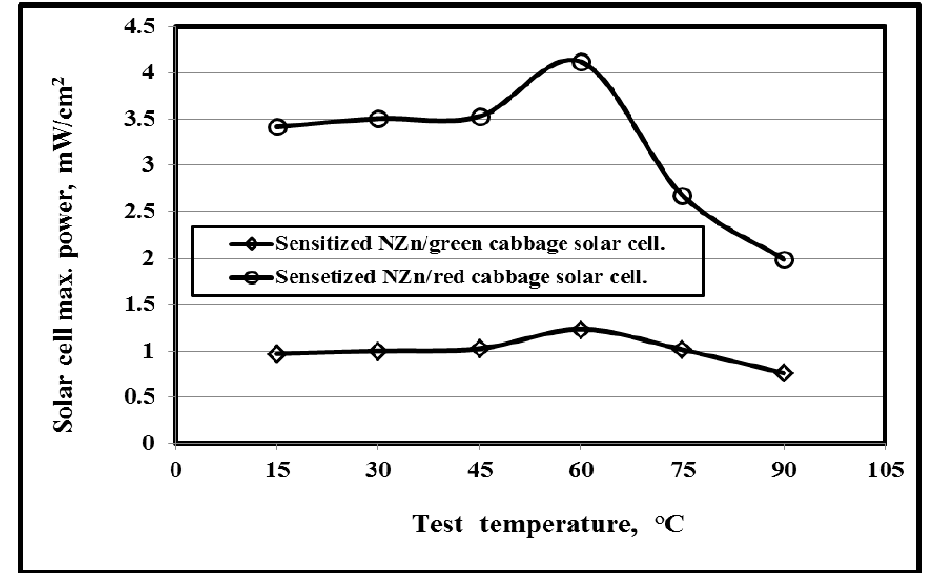
Figure 16. Max. power/temp. relation for RC and GC.